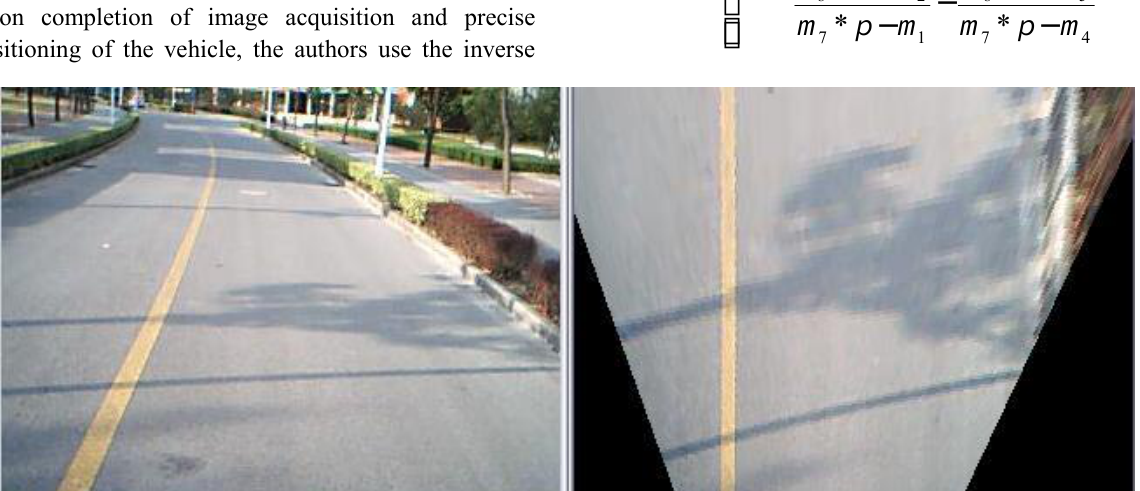
Fig.4. This is the result of inverse perspective